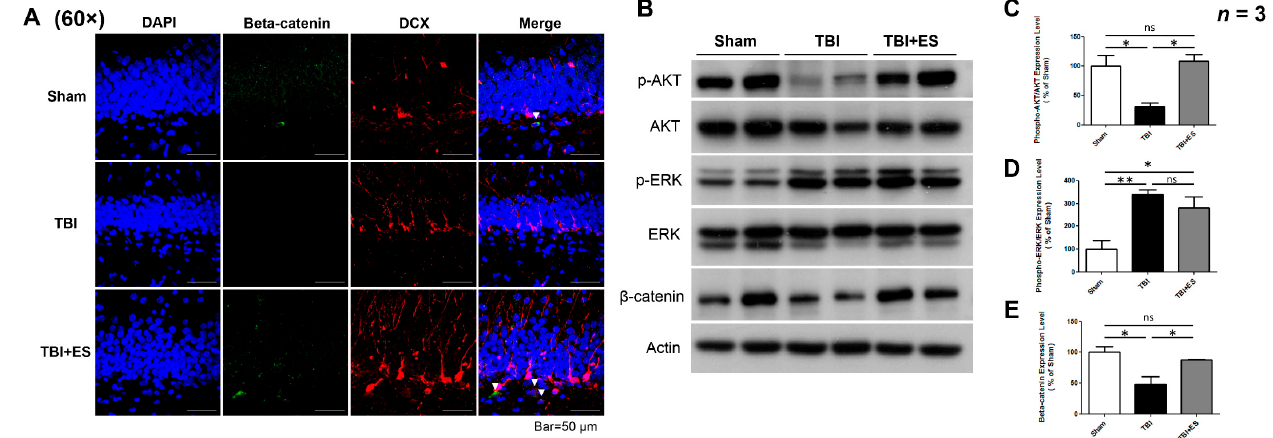
Figure 8. CES upregulates PI-3 kinase/Akt, MEK/ERK, and Wnt/ β -catenin signaling pathways. ( A ) Representative fluorescence images of Beta-catenin (green), DCX (red), DAPI (blue), and merged picture. ( B ) Representative image of western blot. ( C ) Quantification of Akt phosphorylation pre- sented as the ratio of phosphorylated Akt (phospho-Akt) to total Akt. The data showed significantly downregulated phospho-Akt on the 18th day post-TBI, whereas CES treatment restored the down- regulation. ( D ) The quantification of Erk phosphorylation (phospho-Erk) demonstrated signifi- cantly upregulated ERK phosphorylation, but CES did not further increase the upregulation. ( E ) The quantification of β -catenin showed the significant downregulation of β -catenin expression after TBI and CES treatment returned the expression level. Values are expressed as the mean ± SEM. ns, no significance; ** p < 0.005; * p < 0.05.